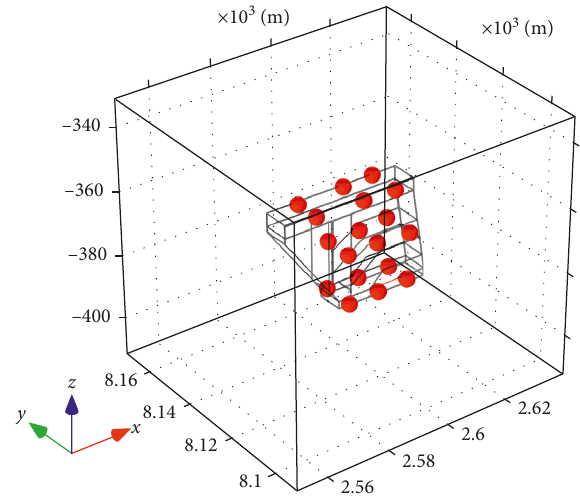
Figure 8: Three-dimensional display of characteristic monitoring points.